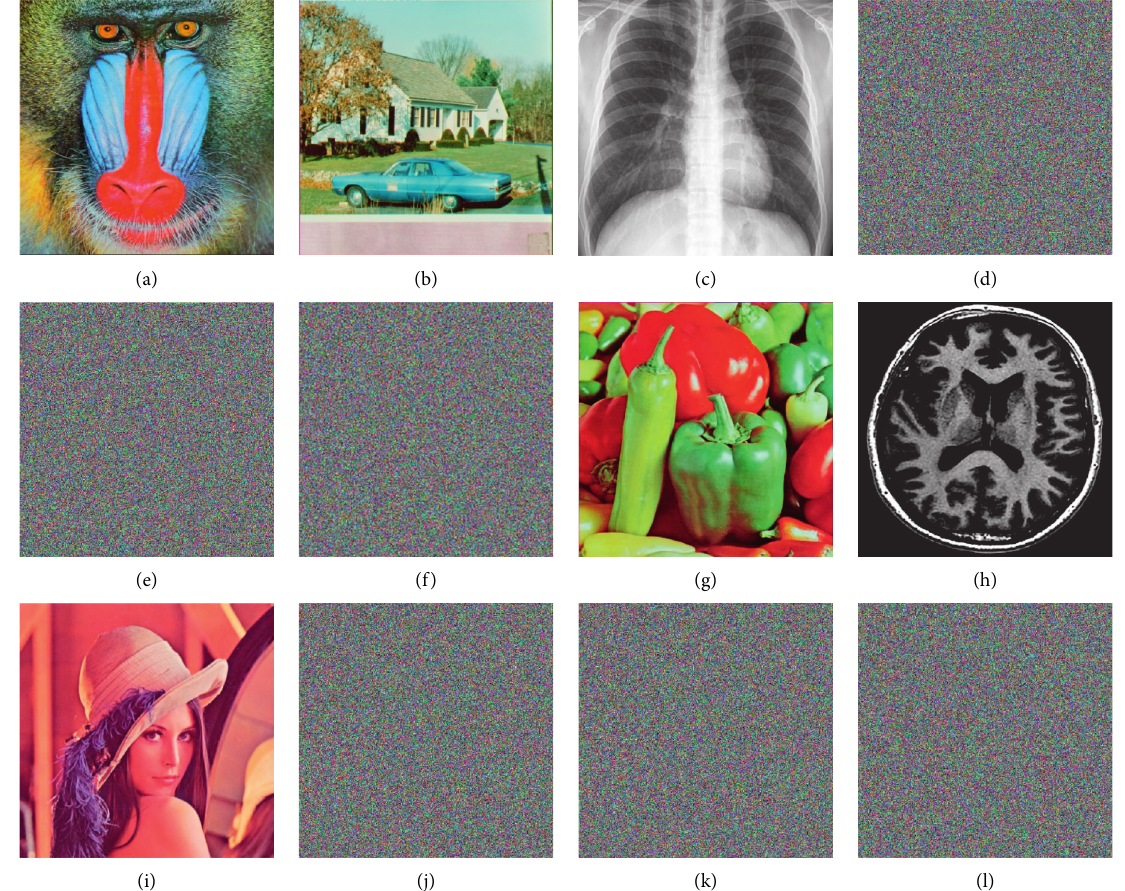
Figure 4: (a-c), (g-i) Original standard images of size 512 × 512; (d-f), (j-k) Respective cipher